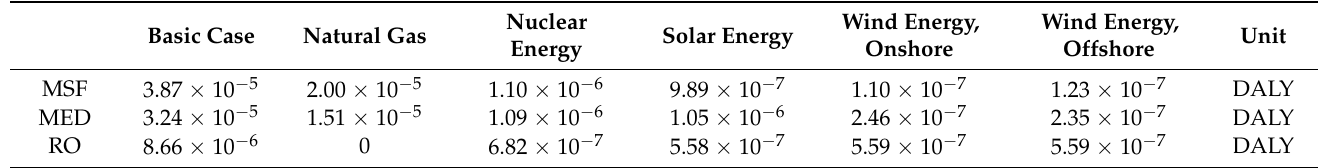
Figure 14. Comparison of desalination technologies used with different energy sources with the human health category based on the IMPACT 2002+ method. Table 8. Summary of impact assessment results for the human health category for the three technologies used with different energy sources based on the ReCiPe 2016 method.